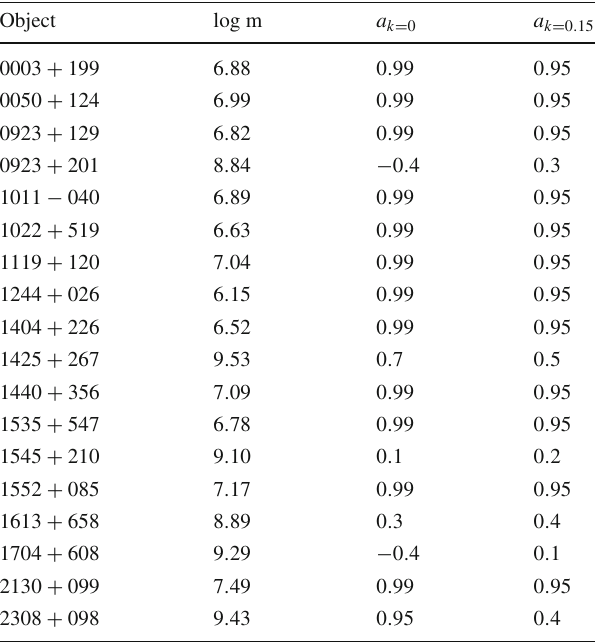
Table 1 Estimates on spin parameters of the quasars corresponding to k = 0 and k (cid:2) 0 .